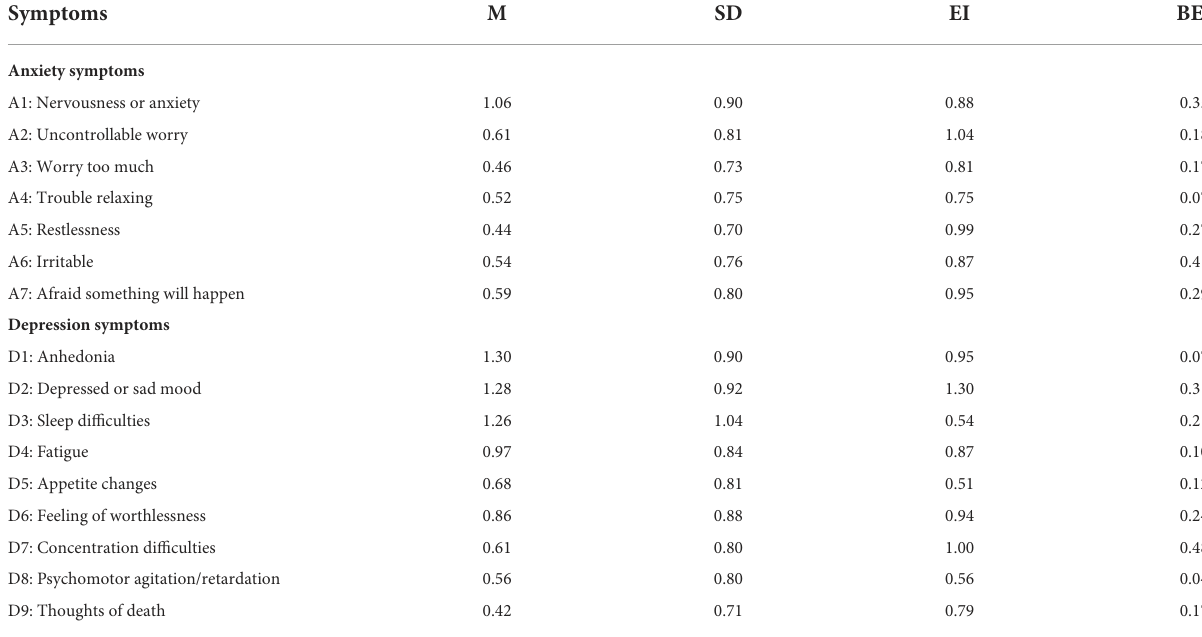
TABLE 2 The means, standard deviations, expected influences and bridge expected influences of the symptoms in the anxiety-depression network. Symptoms M SD EI BEI Anxiety